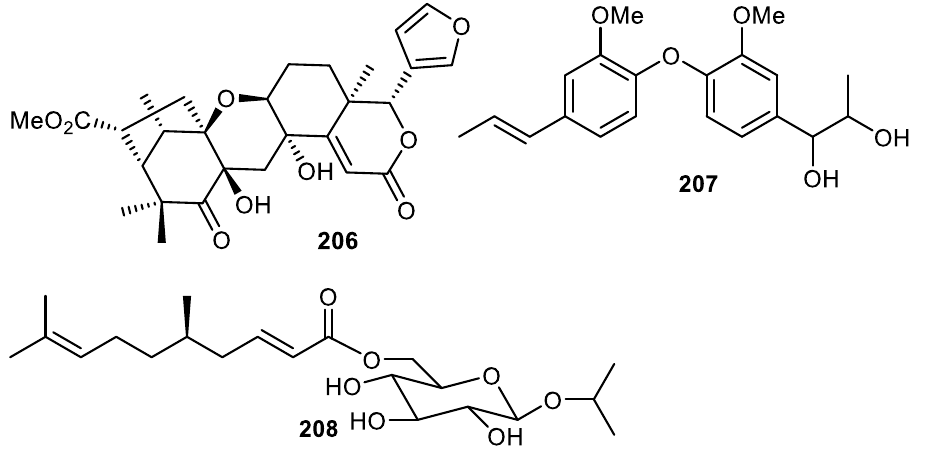
Figure 25. Structures of compounds 206 – 208 .